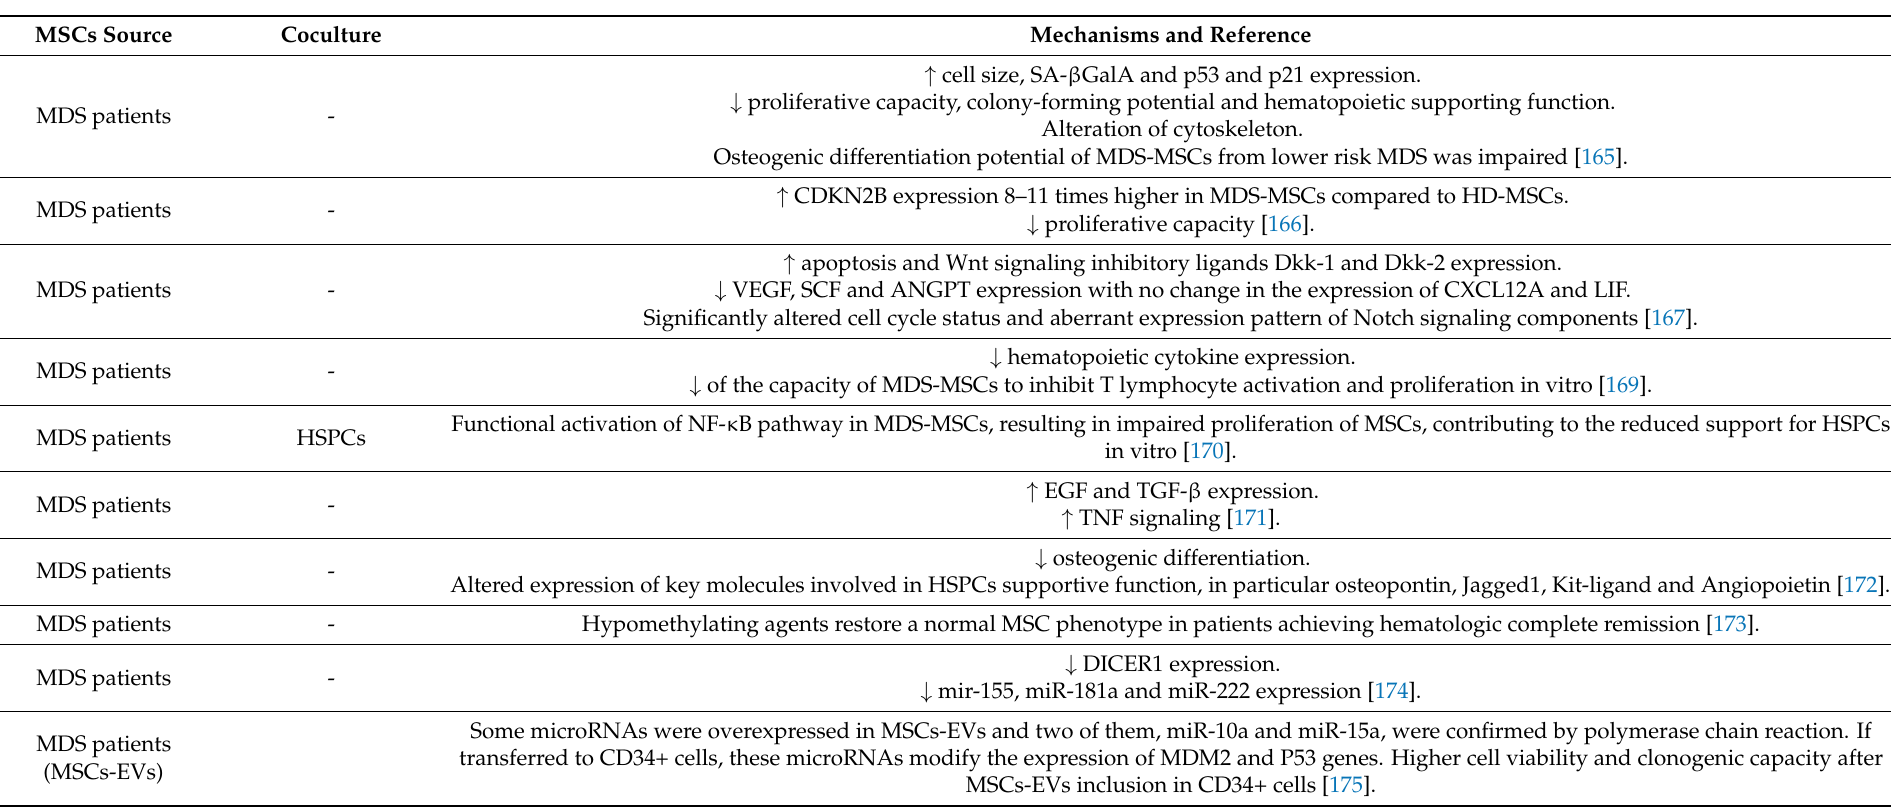
Table 3. Studies evaluating the activity of MSCs in MDS, with focus on MSCs senescence-like modifications.